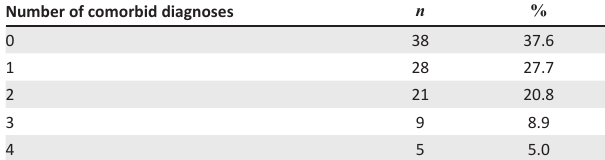
TABLE 2: Number of psychiatric disorders in total population ( N =